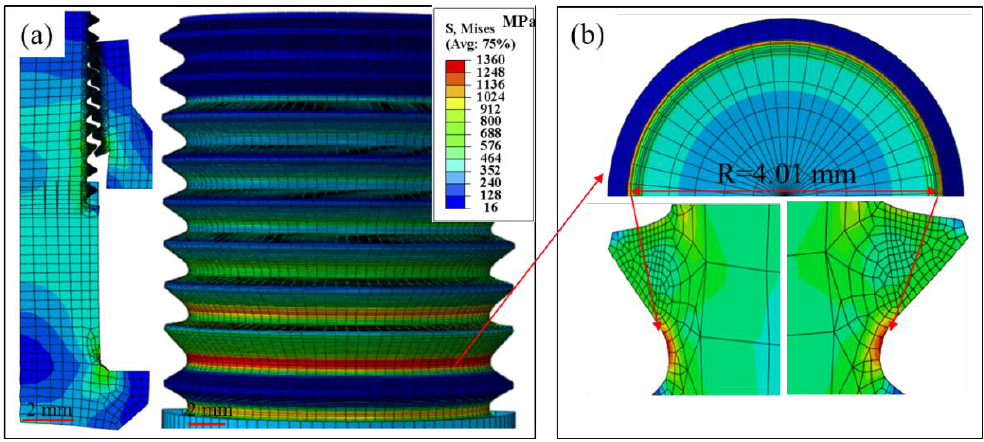
Figure 5. Stress distribution of the bolt under a preload, ( a ) stress nephogram of thread, ( b ) stress distribution of the thread root from cross section